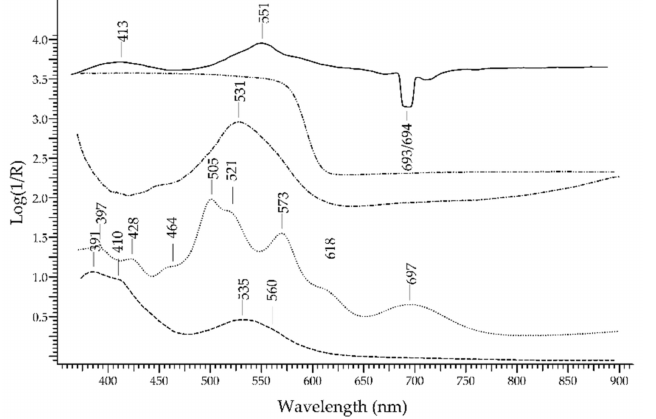
Figure 22. FORS spectrum in Log(1/R) coordinates of ruby (solid line), red spinel (dashed line), ruby garnet (dotted line), red tourmaline (dashed–dotted line) and a ruby-like glass (dashed–dotted–dotted